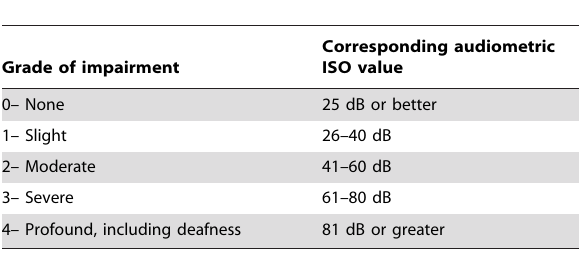
Table 3. Grades of hearing impairment